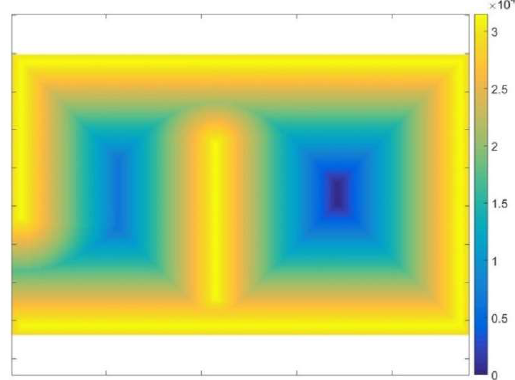
Figure 12. The cost map of the static representation for Dataset I.